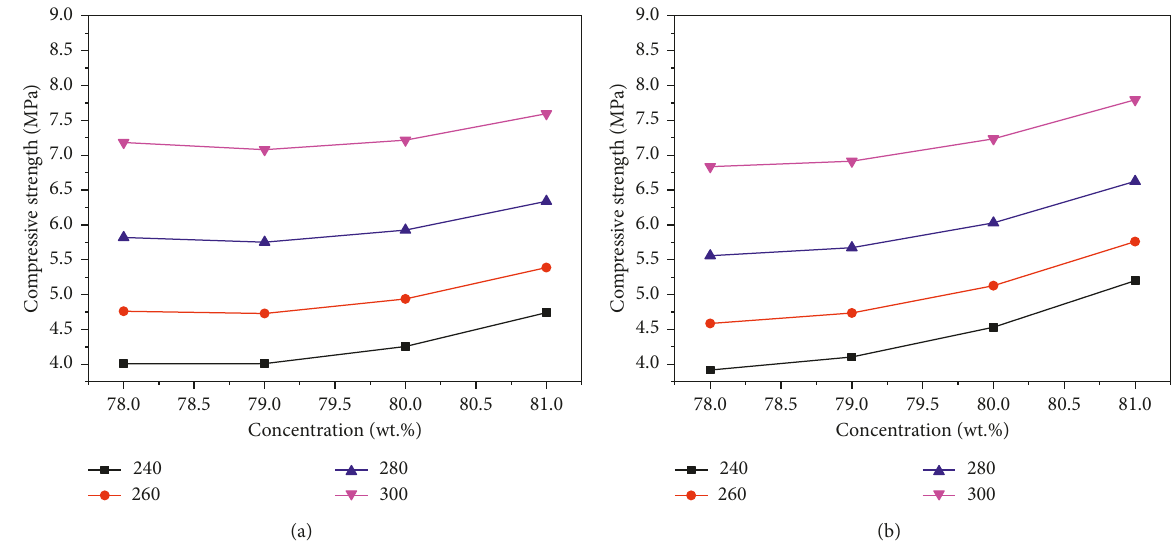
Figure 3: Change in normalized UCS with weight concentration for all CPB samples. (a) Tailings-waste ratio 3:7. (b) Tailings-waste ratio